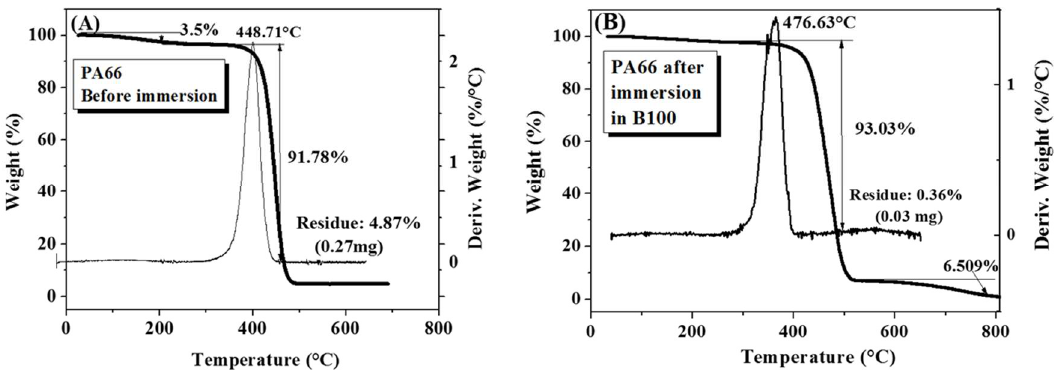
Figure 7. TGA curves of the PA66 samples. ( A ) Before immersion; ( B ) after immersion in B100.